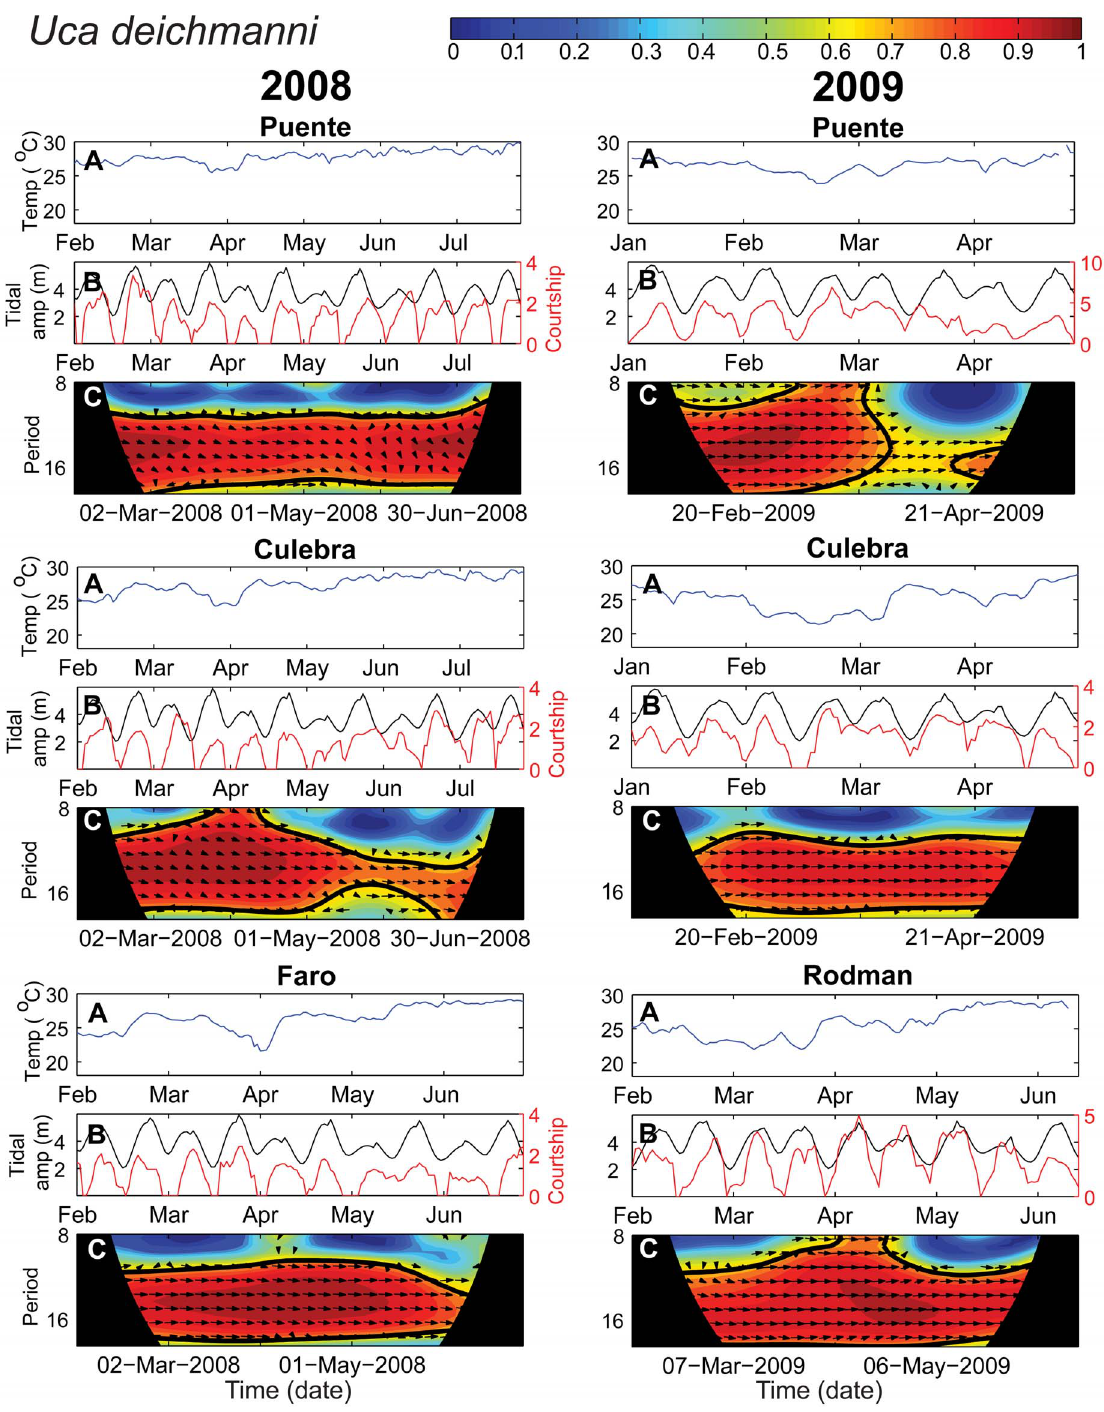
Figure 5. Temperature, tidal amplitude and Ucadeichmanni courtship intensity. Wavelet coherence results for U. deichmanni courtship and tidal amplitude for three sites in 2008 and 2009. Panels A, B and C as explained for Figure 3. Only the period lengths (y-axis) of approximately one tidal amplitude cycle (12–17 days), the area of interest, and a buffer of a few days on either side are shown in plot C.